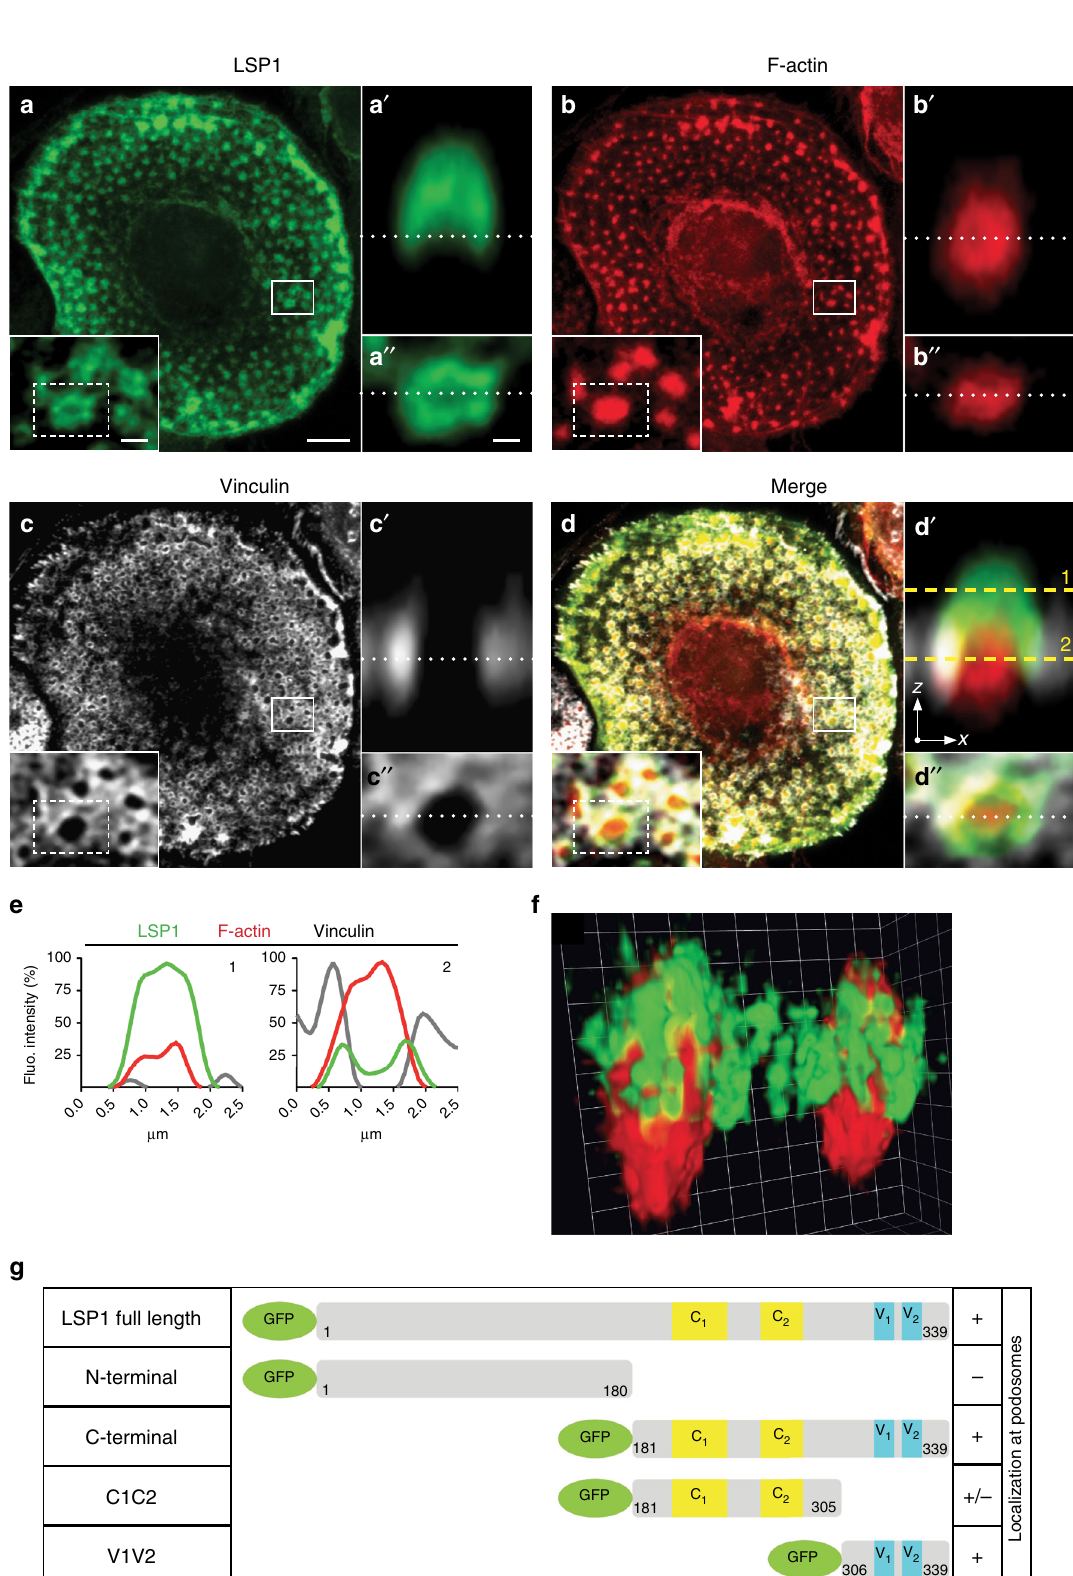
(Supplementary Fig. 4B – G). Podosome dynamics were analysed by confocal live cell imaging of cells expressing lifeact-RFP. Each frame of a respective video (1 h duration) was color coded for time, moving structures thus appear in multiple colors, while static ones are white. Accordingly, stationary macrophages